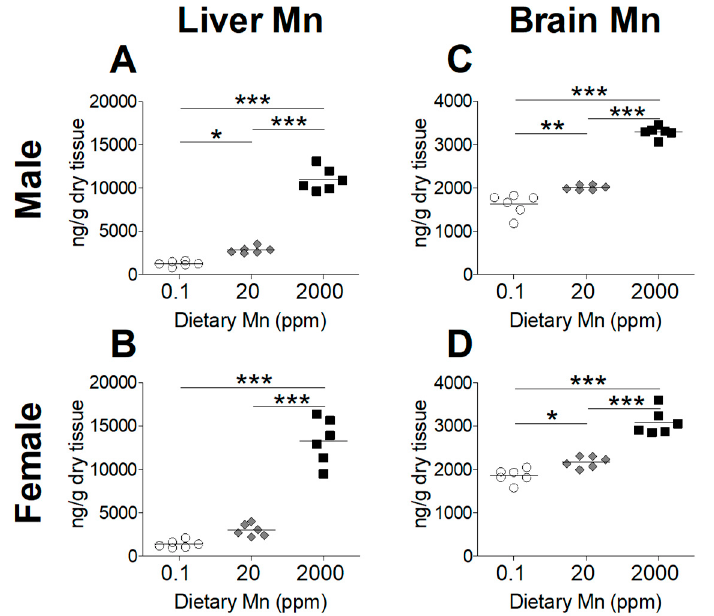
Figure 3. Tissue Mn levels in mice on 0.1, 20, and 2000 ppm Mn diets. Mn content measured by ICP- MS in male and female mice at 12 weeks of age ( n = 6/sex). (A and B) Liver. (C and D) Brain. Data expressed as mean ± SEM. * p < 0.05, ** p < 0.01, *** p < 0.001.